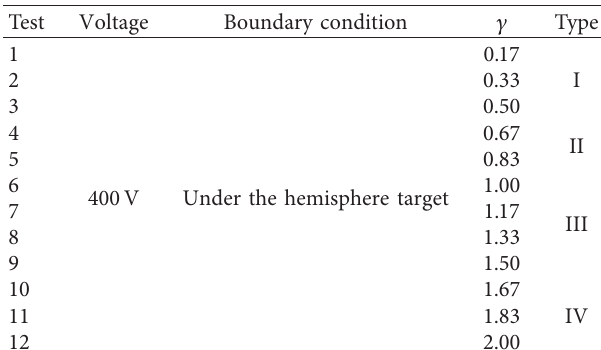
Table 3: Experimental